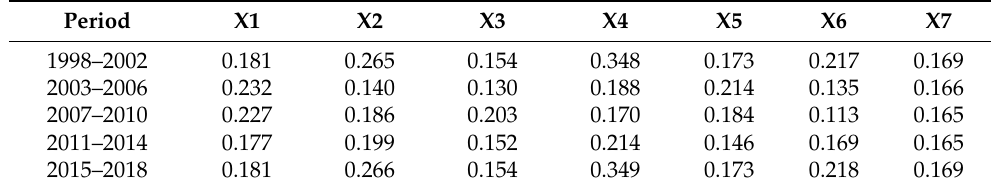
Table 2. Driving factors of the coupling degree between CLP and economic